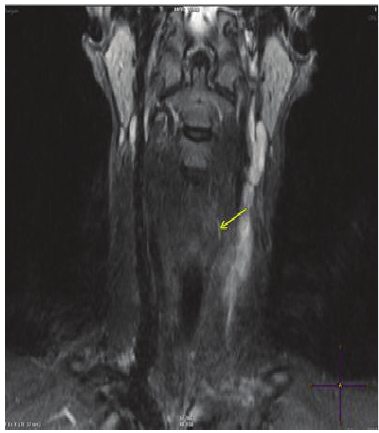
Figure 4: T1 MRI coronal view after injection.